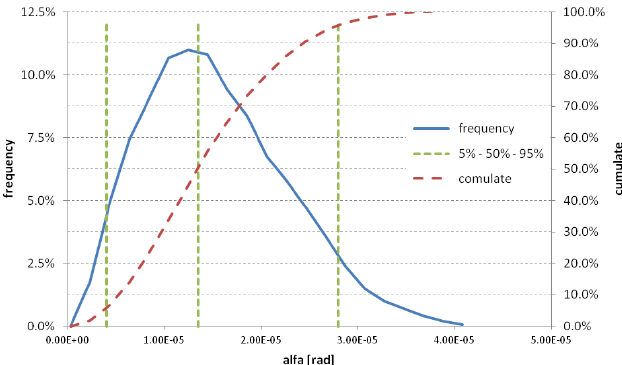
Fig. 7. Orthogonality t and angle α , result of 10 000 MCM simulations for the case R = 8 mm, H = 70 mm, L x = L y = 30